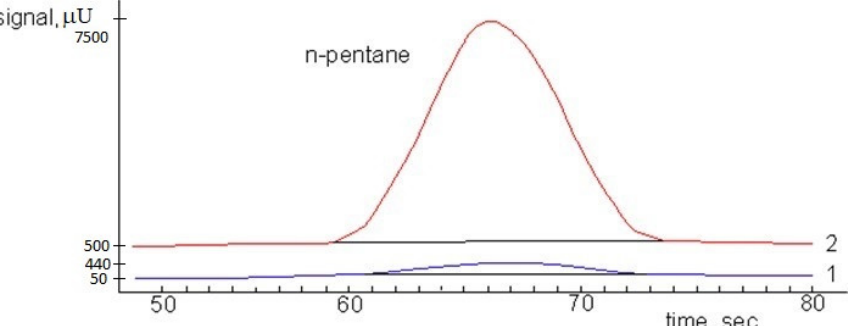
Figure 4. Chromatogram analysis of a mixture of air and n-pentane (concentration 0.5 mg/m 3 ): 1— analysis of the original gas mixture; 2—analysis of the mixture after concentration.